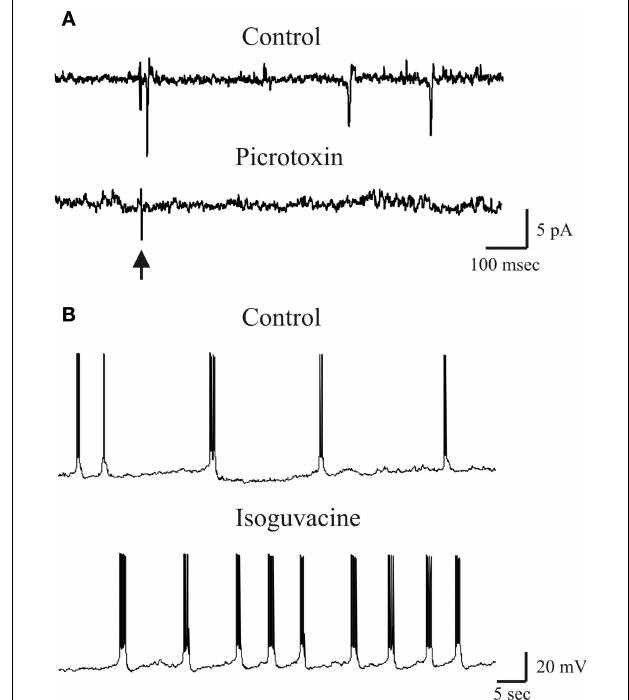
FIGURE 3 | Excitatory action of GABA exerted on a P3 CA3 pyramidal cells. (A) Stimulation of MF in stratum lucidum (arrow) evoked in a P3 CA3 pyramidal cell (recorded in cell-attached) an action potential that was abolished by picrotoxin (100 µM). (B) GDPs recorded from a P3 CA3 pyramidal neuron (whole cell under current-clamp conditions) before (control) and after bath application of Isoguvacine (3 µM). Note the increase in GDPs frequency in